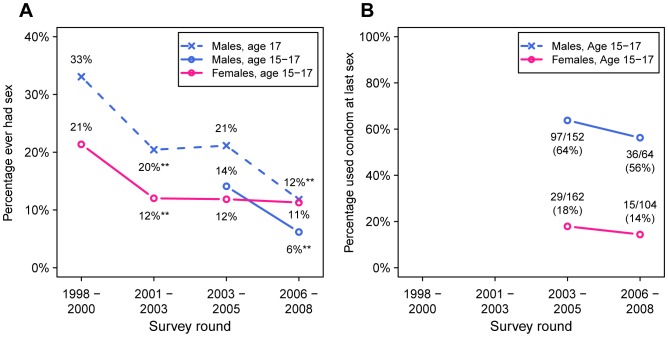
Trends in reported sexual behaviour amongst adolescents age 15 to 17 years.Panel A shows the percentage of adolescents in each cohort who report ever having had sex. Panel B indicates the percentage of respondents who reported using a condom at their last sex, amongst those who have ever had sex. Asterisks denote a statistically significant decline between cohorts (two-sided Fisher’s exact test, all significant at level P<0.001). Because males were only enroled from the age of 17 in the first two survey rounds, the dashed blued line shows the trend in the proportion of sexually experienced 17 year-old males, and the solid blue line shows the trend for 15 to 17 year-old males in the two most recent rounds.